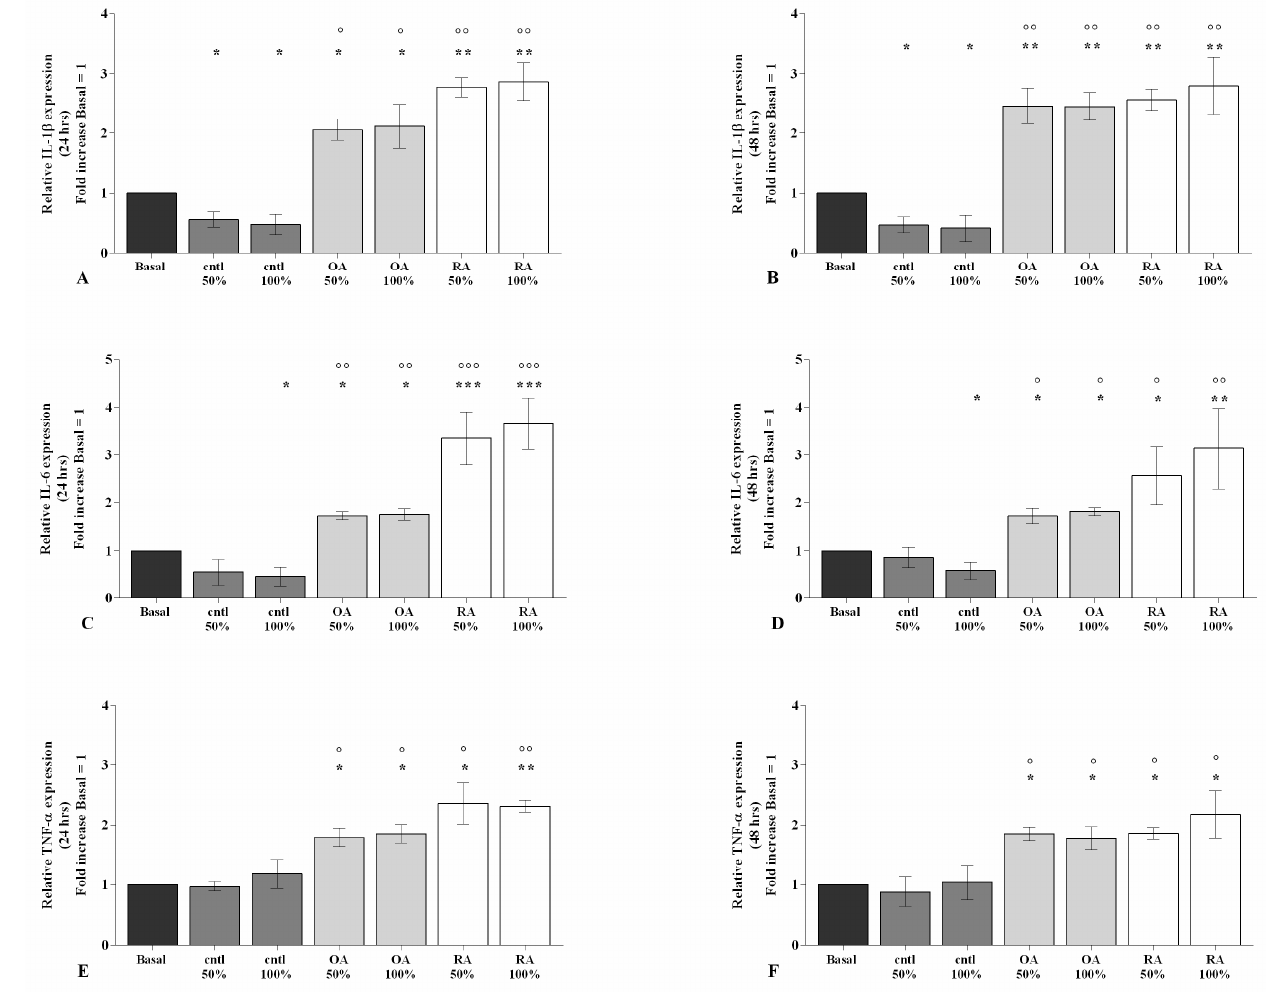
Figure 2. SF regulation on inflammation. Human osteoarthritic (OA) chondrocytes were incubated for 24 h and 48 h with 50% and 100% SF derived from patients with OA, rheumatoid arthritis (RA), or controls. ( A – F ) Expression levels of interleukin ( IL ) -1β , IL-6 , and tumor necrosis factor ( TNF ) -α analyzed by quantitative real-time PCR. The gene expression was referenced to the ratio of the value of interest and the value of basal condition, reported equal to 1. Data were represented as mean ± SD of triplicate values. * p < 0.05, ** p < 0.01, *** p < 0.001 versus basal condition. ◦ p < 0.05, ◦◦ p < 0.01, ◦◦◦ p < 0.001 versus control